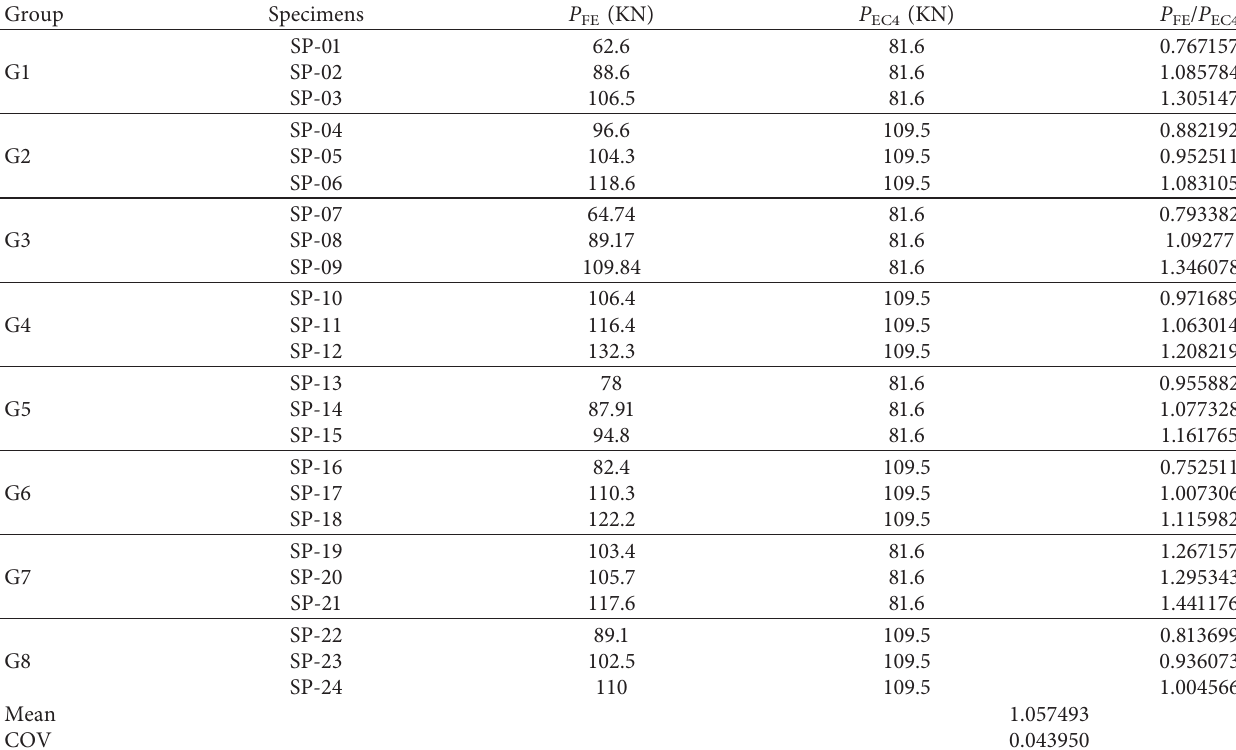
Table 5: Summaries of finite element analysis and Eurocode prediction of shear connector capacity for all model specimens. Group